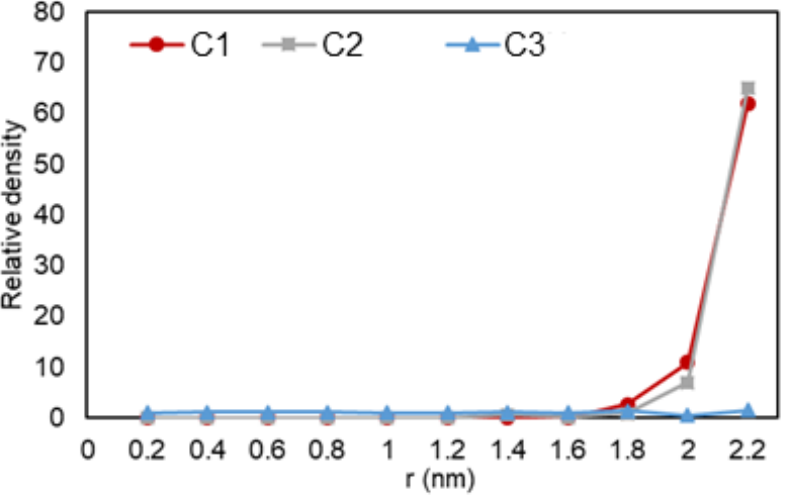
Figure 9. Ethane relative density (mass density inside the pore over the density of the phase in bulk condition) vs. radial position in C1 (gas phase in bulk), C2 (two-phase in bulk), and C3 (liquid phase in bulk) conditions.